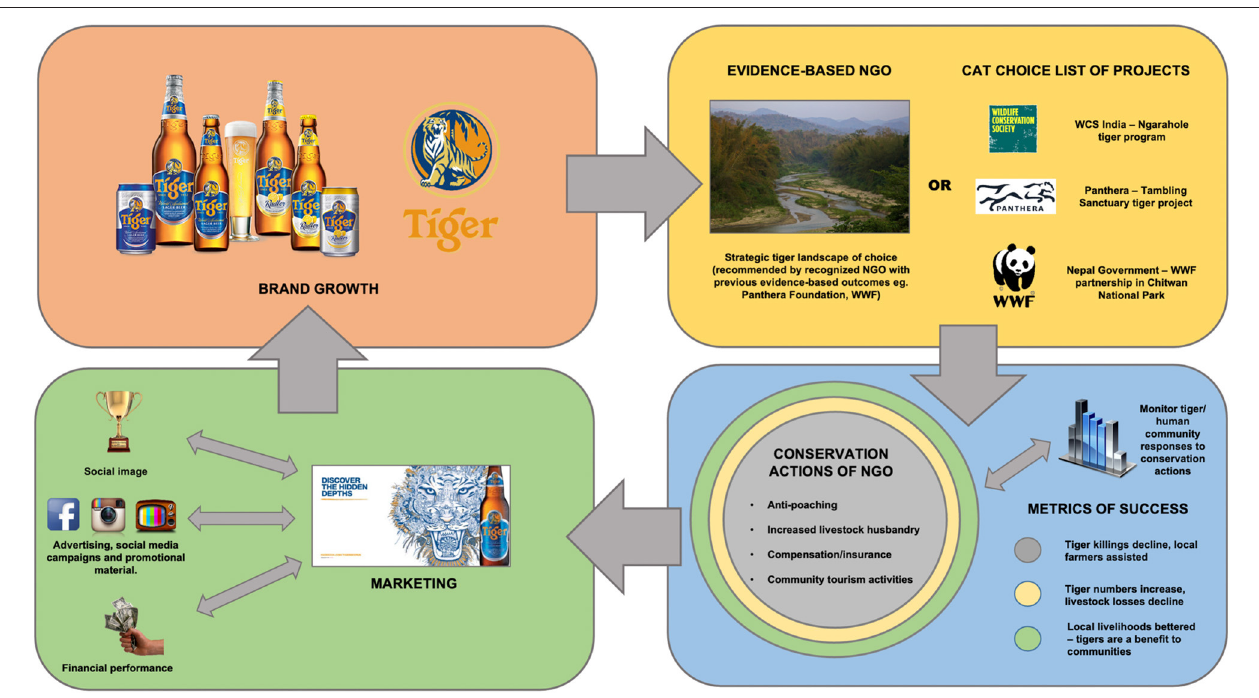
FIGURE 3 | A conceptual diagram illustrating the potential benefits from the Heineken Group’s Tiger Beer for hypothetical evidence-based tiger conservation. Tiger Beer donate a percentage of their profits or sales to a strategic evidence-based project or one selected from an accredited Cats Choice List with demonstrated conservation outcomes. Funds are spent on strategic conservation interventions including anti-poaching and snaring patrols ( Rabinowitz, 2009), livestock husbandry and predation deterrents, and compensation or insurance schemes ( Bauer et al., 2015). Conservation actions are evaluated through monitoring of critical population parameters including density, mortality rates, birth, emigration, and immigration. Conservation successes such as a decrease in the killings of tigers, population recoveries, and a change of attitudes by local communities living alongside them are measured quantitatively. Conservation successes are reported to Tiger Beer and used in marketing channels. The CSR activity of Tiger Beer is viewed positively by both company staff and consumers of tiger beer which may, in turn, have a positive bearing on the financial performance of the company. Photograph courtesy of Steve Winter, National Geographic